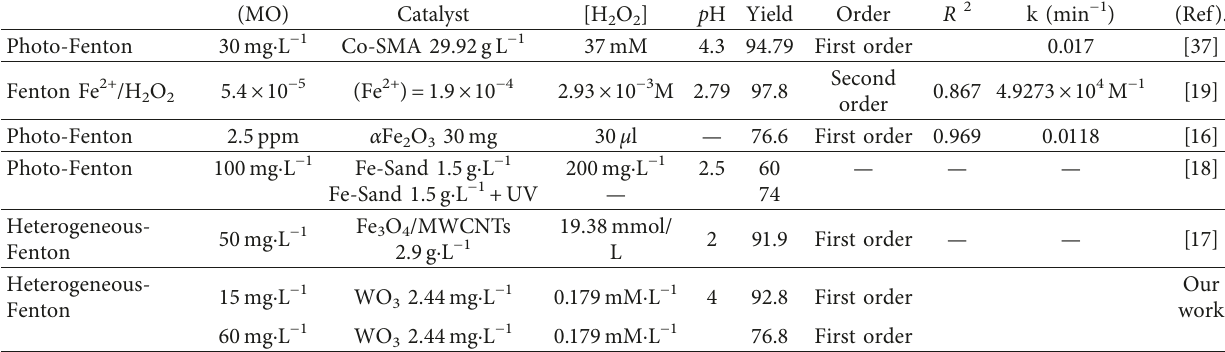
Table 1: Comparison of the efficiency and kinetic parameters of MO removal. (MO)